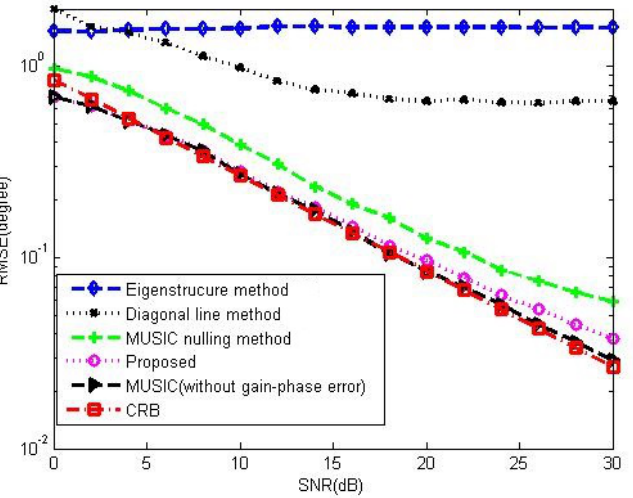
Figure 12. DOA performance comparison among the corresponding methods versus SNR in 5- element ULA with deterministic gain-phase errors, CSR = 30 dB, K 0 = 20, T = 80, N = 40, T 0 = 40.